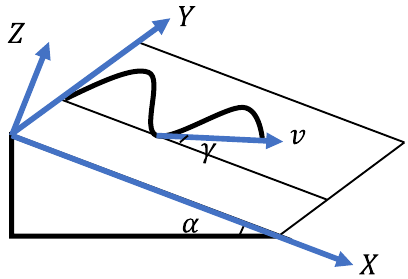
Figure 1. Schematic diagram of track coordinate system.